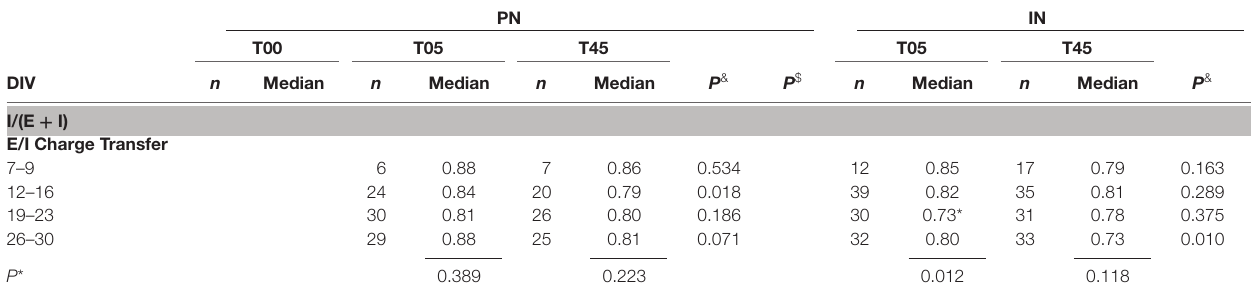
Table 2 ): EPSC charge transfer was increased in T45 compared with T05 during the 2nd week in PNs ( Table 2 , Figure 10A )